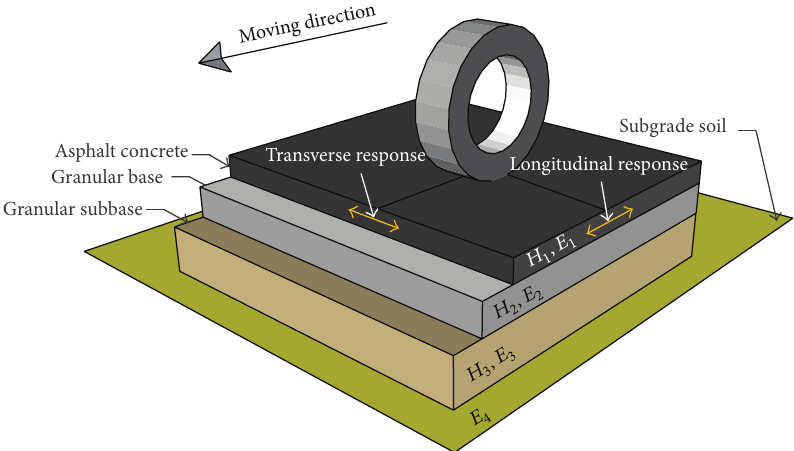
Figure 1: Characteristics of the Pavement structure and tensile